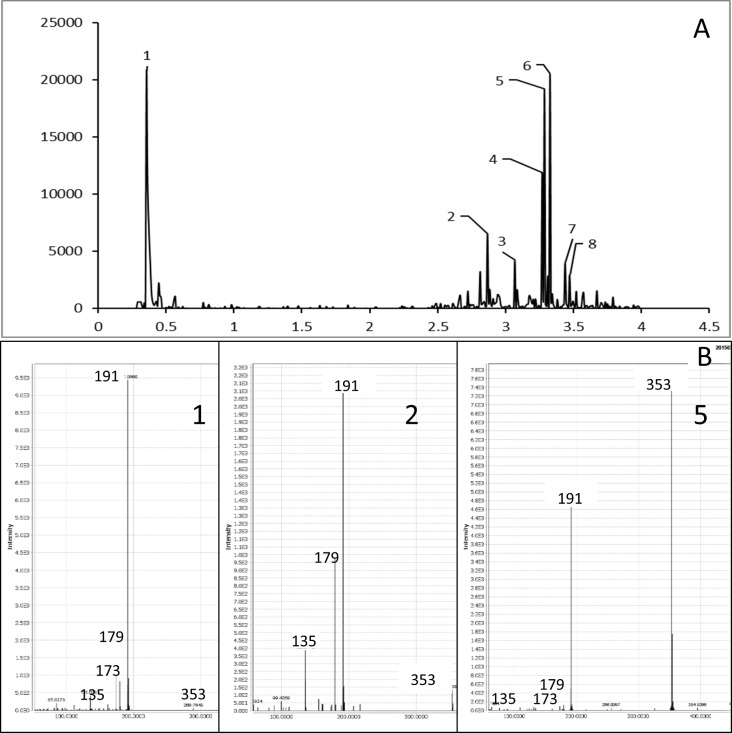
Total ion chromatogram (TIC) of F1fraction from CO97216-1P/P tubers in ESI—ve mode (A). MS/MS spectra of peaks 1,2, and 5 (B).